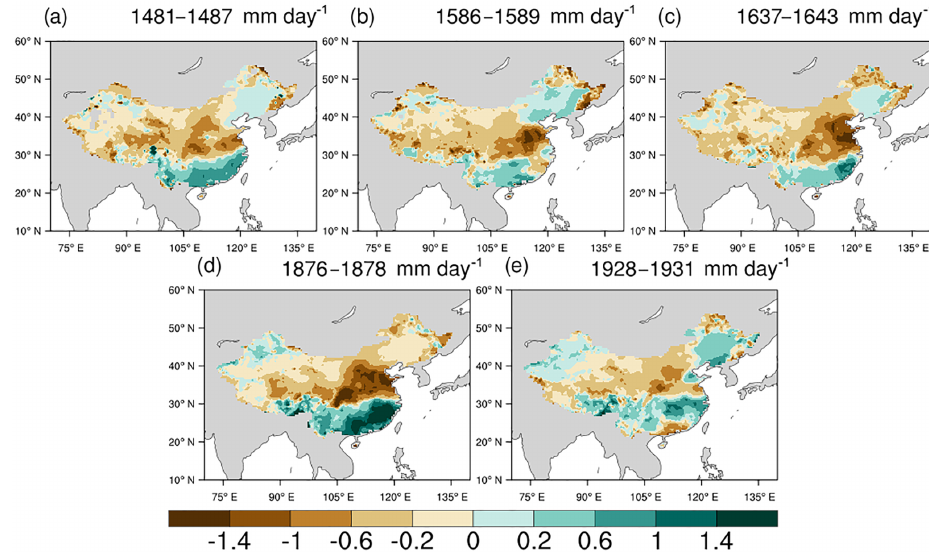
Figure 6. Spatial patterns of the May–September precipitation field relative to the 1961–1990 climatological mean during five severe droughts in China.